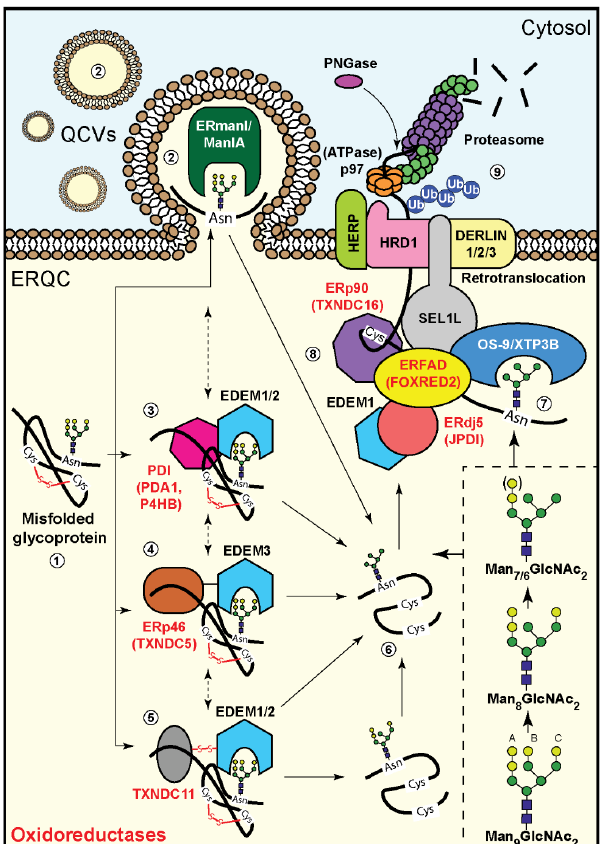
Figure 2. N-Glycan processing and ERAD in mammalian cells. (1) Misfolded glycoproteins carrying Man 9 GlcNAc 2 are targeted to the ER-derived quality control compartment (ERQC), and their N-glycans are subjected to mannose trimming for their recognition by the ERAD machinery. A scheme on the right depicts mannose trimming of α 1,2 mannose residues (light green circles, other mannoses are in dark green, and blue squares are GlcNAc). (2–5) This processing is performed sequentially or in parallel by the α 1,2 mannosidases EDEM1-3, ManIA, or ERmanI. (2) ManIA or ERmanI (and possibly the EDEMs) reside in quality control vesicles (QCVs) and interact with the misfolded glycoproteins, likely at vesicle fusion sites. Several oxidoreductases interact with the EDEMs–(3) PDI (PDA1, P4HB) and (5) TXNDC11 associate with EDEM1 and 2, while TXNDC11 and (4) ERp46 (TXNDC5) associate with EDEM3. The associations of the oxidoreductases accelerate the mannose trimming activity of the EDEMs on misfolded glycoproteins, as shown so far for PDI and TXNDC11 with EDEM1 / 2 and ERp46 with EDEM3. (6,7) Trimming of three or all four α 1,2 mannose residues results in glycoprotein molecules carrying Man 5-6 GlcNAc 2 N-glycans, which bind to the OS-9 / XTP3B lectins that interact with the ERAD complex. (7) OS-9 interacts with SEL1L, an adaptor protein for the E3 ubiquitin ligase HRD1, which associates with the membrane proteins Herp and the Derlins 1–3, among others. (8) OS-9 and SEL1L also interact with a complex of proteins containing Trxl domains, the non-catalytic ERp90 (TXNDC16), and the reductase ERdj5. ERp90 associates with the NAPDH-dependent reductase ERFAD. ERdj5 also interacts with EDEM1. These complexes lead to misfolded glycoprotein reduction, polyubiquitination, and retrotranslocation, with the help of the AAA ATPase p97 on the cytosolic side. (9) Peptide:N-glycosidase (PNGase) removes the N-glycans prior to deubiquitylation and degradation of the misfolded glycoproteins by the proteasomes. For simplicity, several ERAD components, such